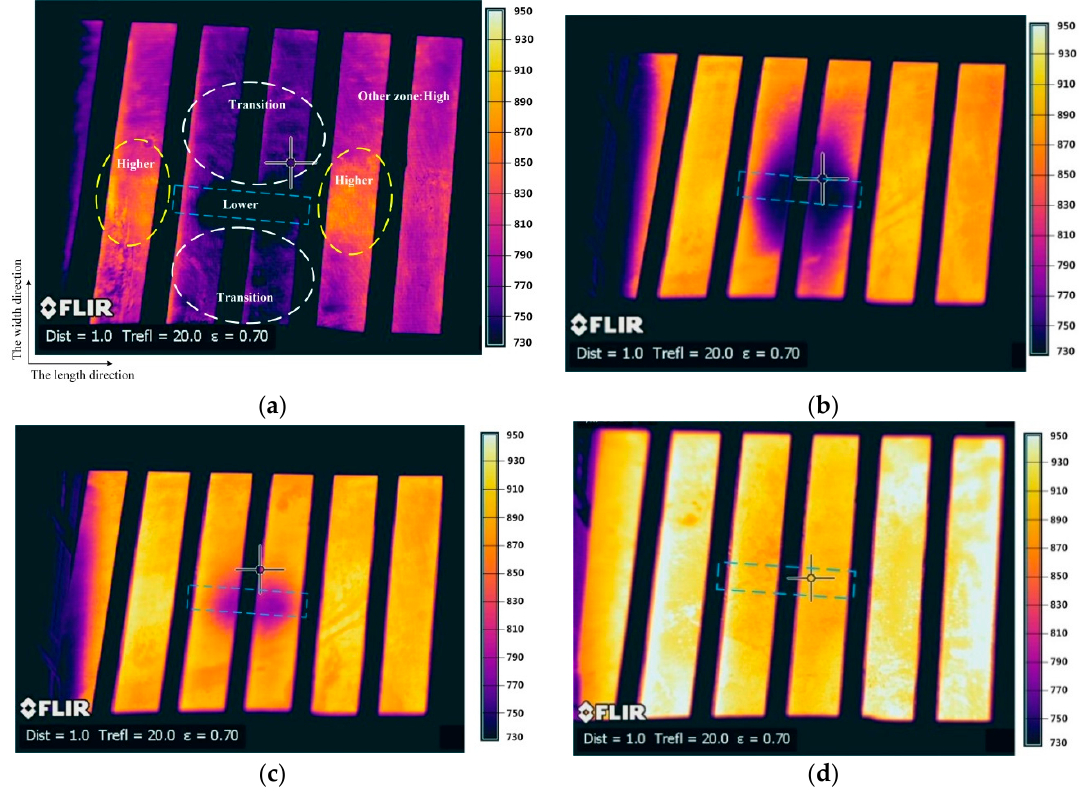
Figure 4. The thermal image of the steel blank during localized induction heating. ( a ) t = 20 s; ( b ) t = 22 s; ( c ) t = 24 s; and ( d ) t = 30 s.